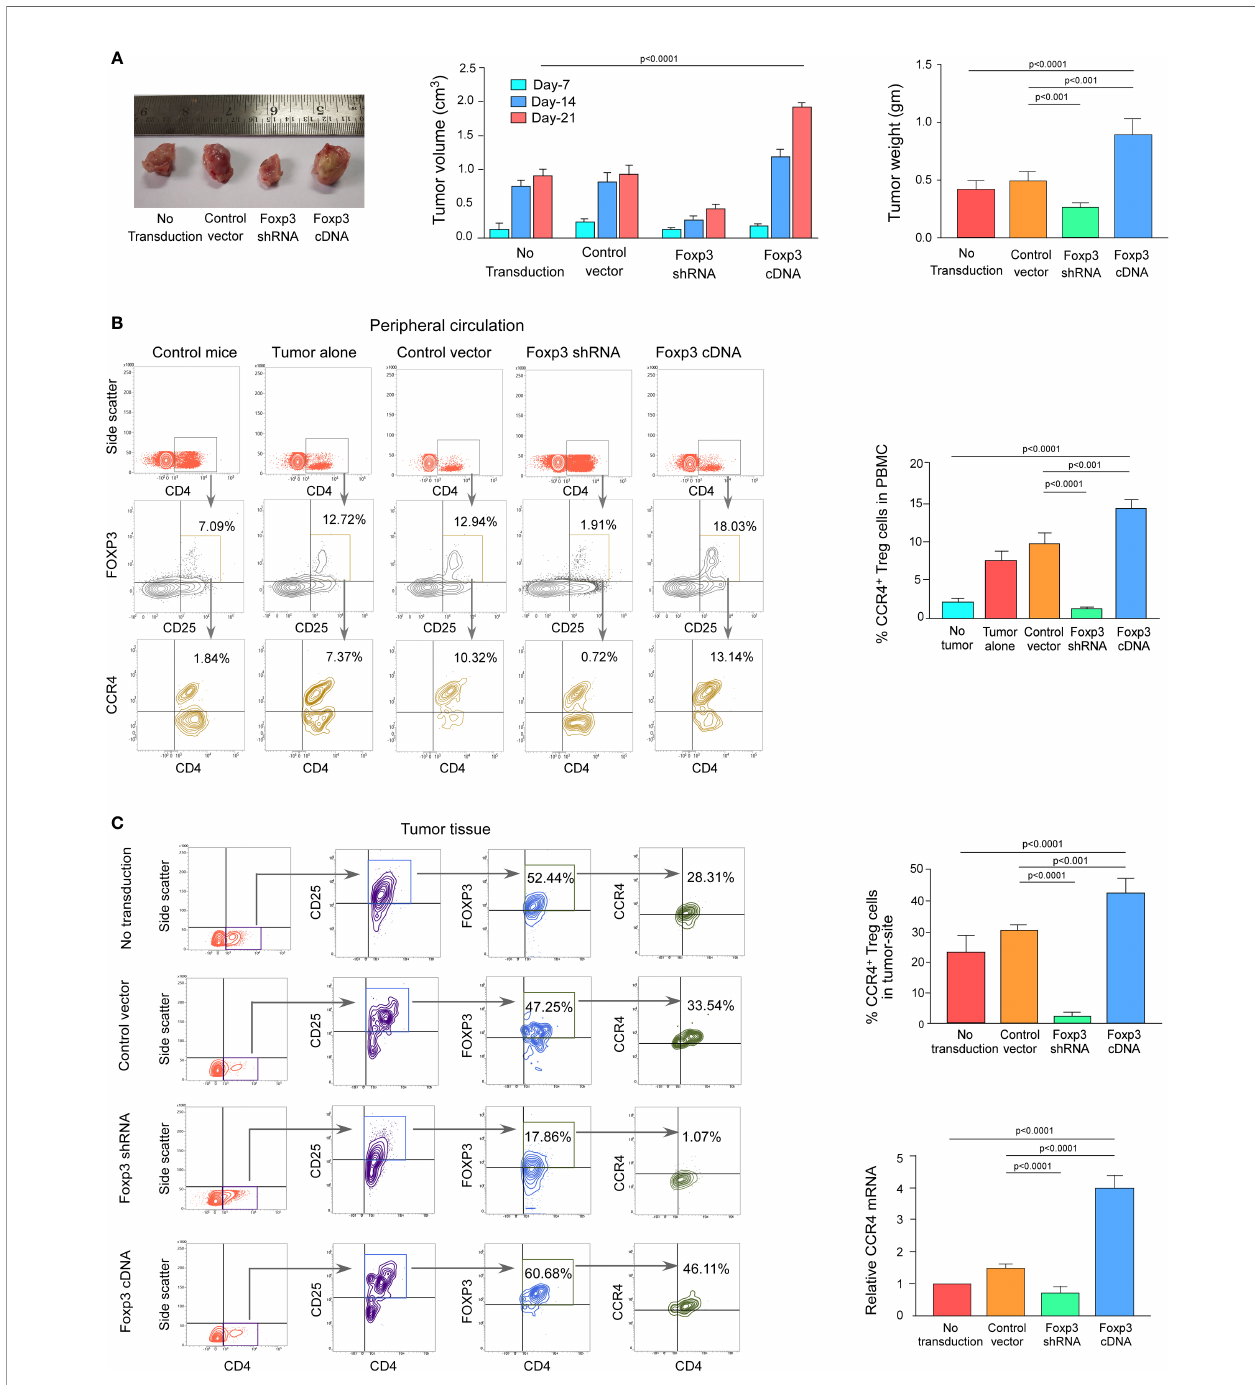
FIGURE 5 | FOXP3 regulates Ccr4 transcription and in fi ltration of Tregs in mouse mammary carcinoma site. (A) In the tail veins of isogenic mammary cancer (4T1)- transplanted BALB/c mice, lentiviruses expressing Foxp3-shRNA or Foxp3-cDNA were injected ( n = 6). Mice were sacri fi ced after 21 days, and the tumor was detached (left panel). The volume and weight of the tumor were measured and graphed (middle panel, right panel). CCR4 and FOXP3 positivity in Treg cells from (B) peripheral circulation and (C) tumor site were fl ow cytometrically analyzed (left panels) and graphically plotted (right panels). CCR4-mRNA transcript levels in tumor-in fi ltrating Tregs were measured using real-time PCR and graphed (lower right panel). As an internal control, GAPDH was used. The values are the mean ± SD of two sets of independent experiments performed in